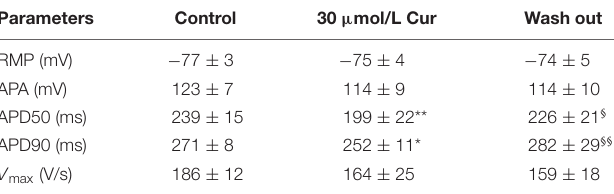
TABLE 1 | Effects of Cur on the parameters of APs in rabbit ventricular myocytes.